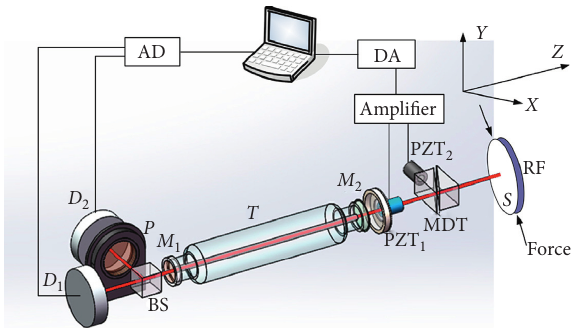
Figure 10: Schematic diagram of birefringence measurement of RLF system [42].